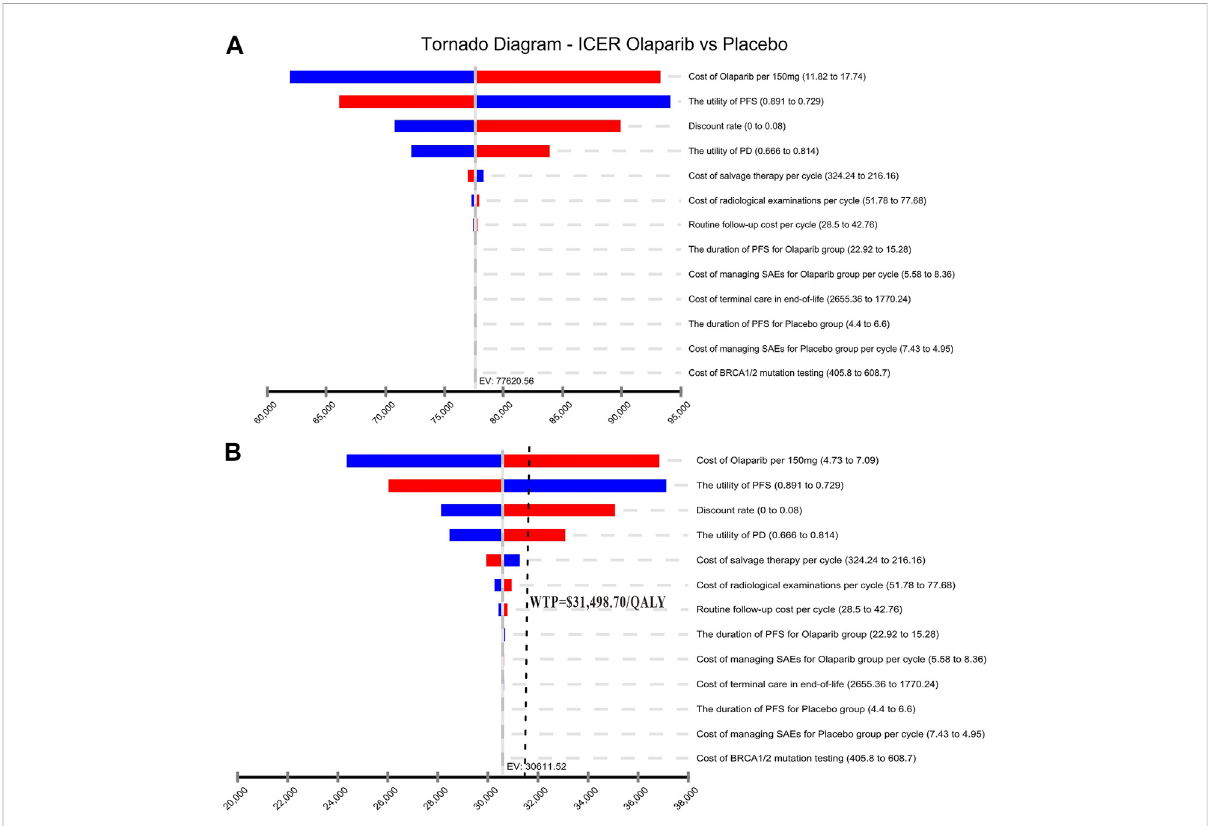
FIGURE 3 Tornado diagram ofone-waysensitivity analysis. It summarized theresults of one-way sensitivity analysis, whichlisted in fl uential parametersin descending order according to their effect on the ICER over the variation of each parameter value. (A) The base case analysis. (B) 60% discount of olaparib. Abbreviations: ICER, incremental cost-effectiveness ratios; PFS, progression-free survival; PD, progressive disease; SAEs serious adverse